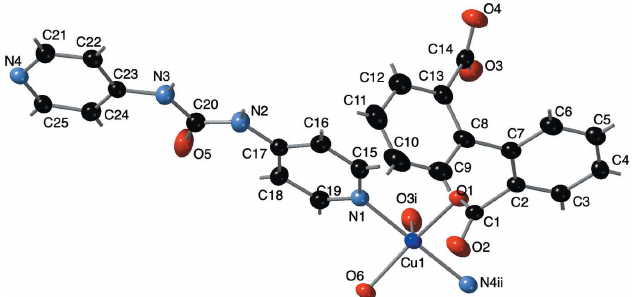
Figure 1 The coordination environment of the title compound, showing the distorted square-pyramidal coordination at the Cu1 atom. Displacement ellipsoids are drawn at the 50% probability level. Color code: Cu, dark blue; O, red; N, light blue; C, black. H atom positions are shown as sticks [symmetry code: (ii) x + 1, (cid:5) y + 3 , z + 1 ]. 2 2